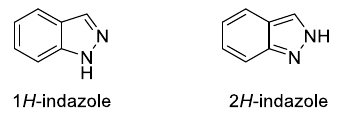
Figure 1. Indazole Figure 1. Indazole nucleus.